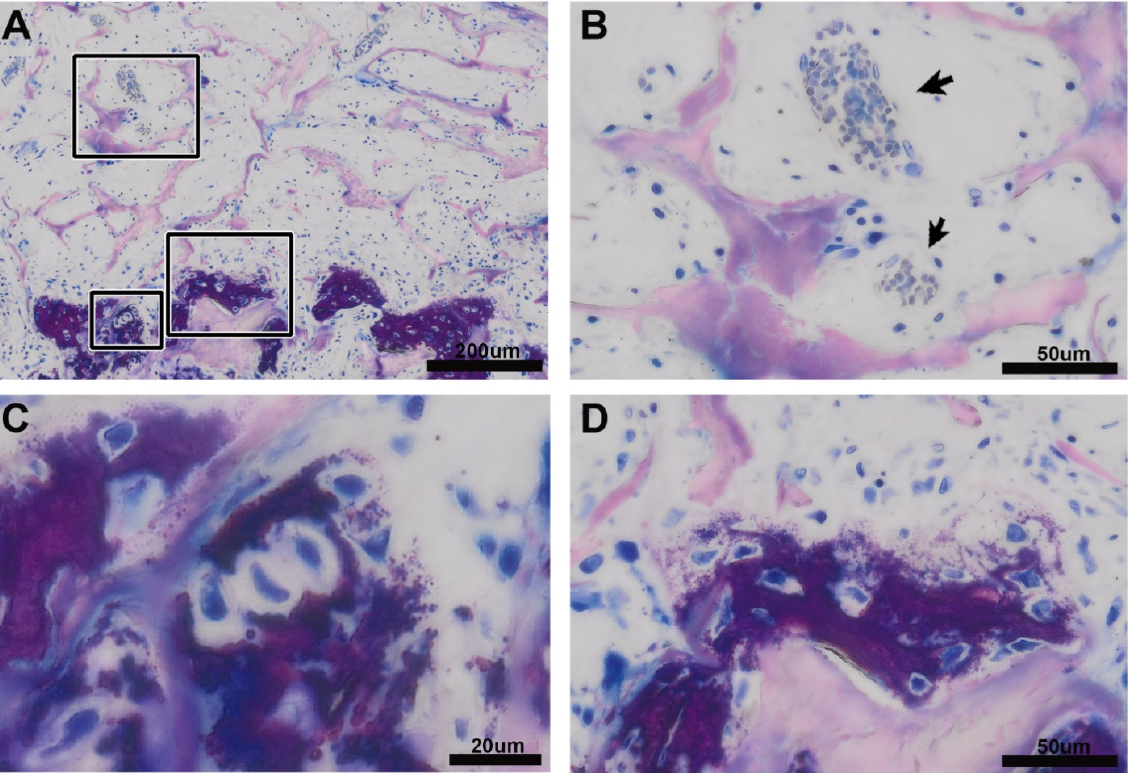
Figure 2. Mineralized extracellular matrix that looks like a hypertrophic cartilage-like tissue. What becomes obvious is that the scattered mineralized tissue appears at a certain distance to the blood vessels ( A ). The blood vessels (black arrows) have sprouted into the VSCM stained in light pink and are characterized by the erythrocytes that appear in light blue stain ( B ). Impressively is the morphology of the mineralizing cells that occasionally form staples, the hallmarks of hypertrophic chondrocytes in the growth plate ( C ) but are also loosely distributed in their mineralized matrix ( D ). The strong uptake of the dye produces a dark purple stain that indicated higher mineralization of the extracellular matrix compared to the pink staining of the classical newly formed bone that is produced by the osteoblasts.